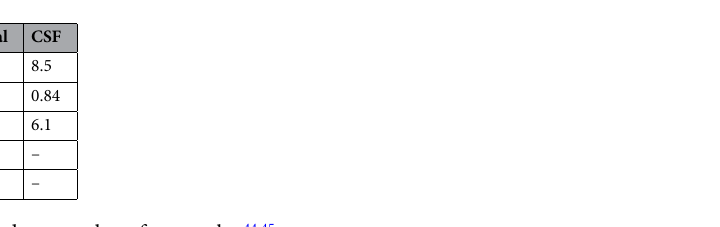
Table 2. The response dose and cancer slope factor value 44,45